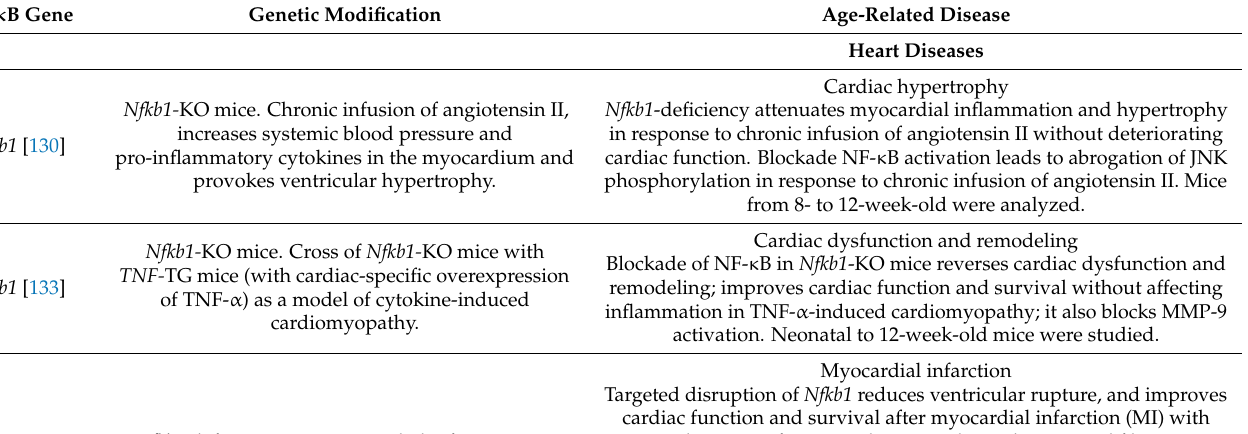
Table 3. Mouse models of the NF- κ B signaling pathway resembling ageing-associated heart diseases. NF- κ B